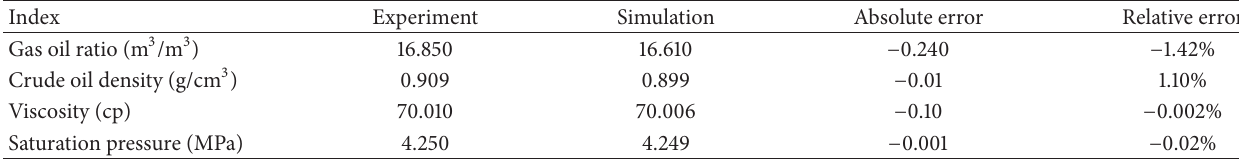
Table 5: The fitted results of single flash tests and saturation pressure (at a reservoir temperature of 59 ∘ C).